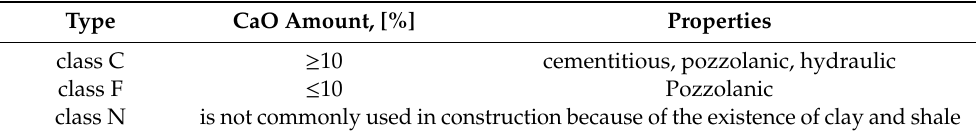
Table 2. Type of fly ash as per American Society for Testing and Materials [26,70].